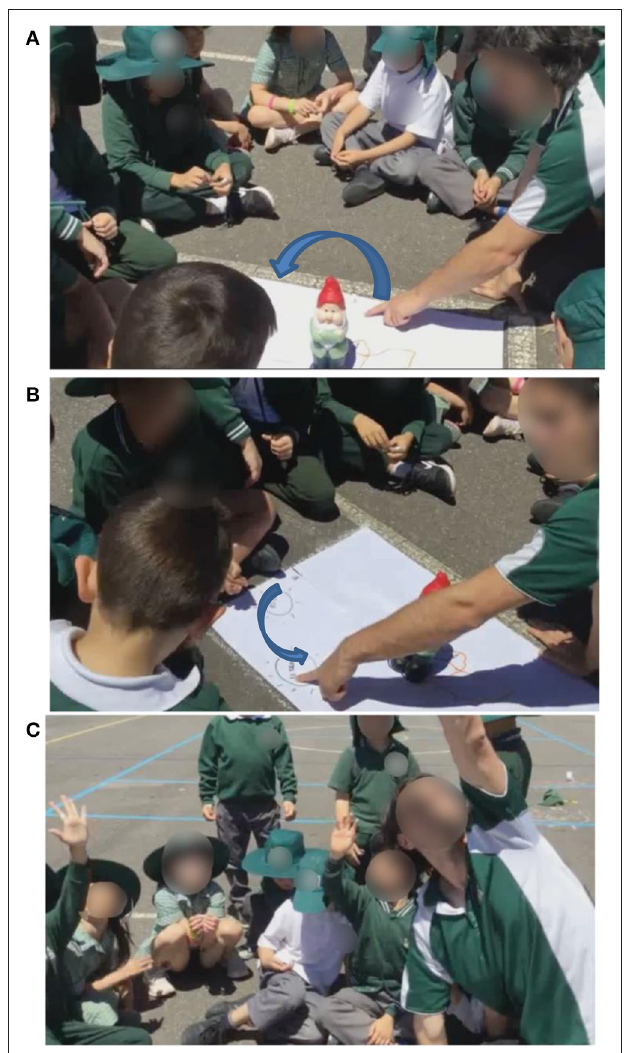
FIGURE 3 | (A) The shadow’s moving toward the south—it looks like its coming around this way. What’s happening to the sun? (B) The sun started here and moved over at 12 o’clock toward. (C) Where do you think the sun is? Where’s it going to be?